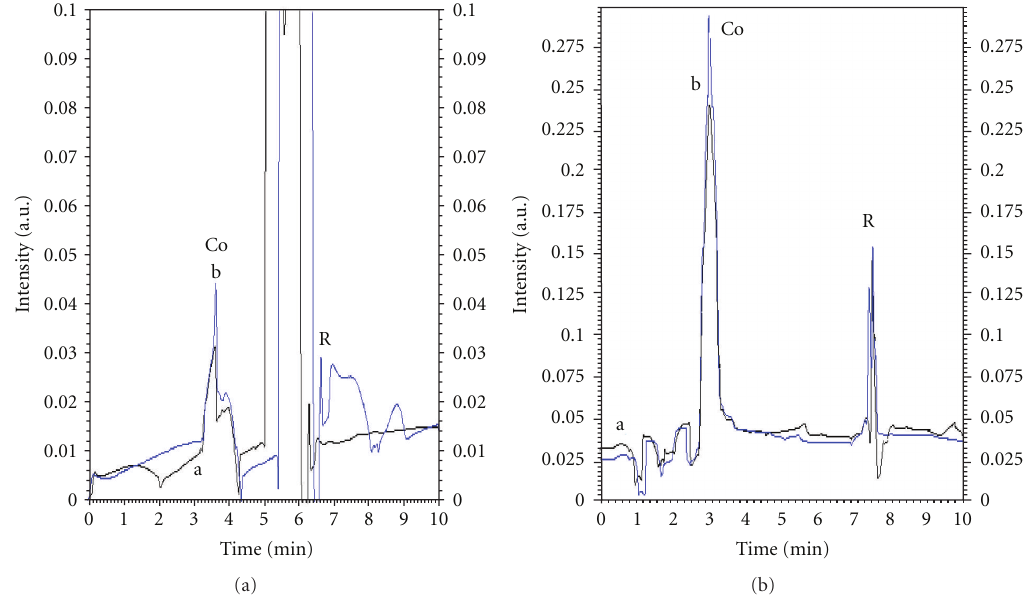
Figure 7: (a) Electropherogram of Co a in Cobalmine injection b spiked with Co 20ppm. (b) Cobalt in Neurobion injection (b) spiked with 10 pmm standard Under optimized